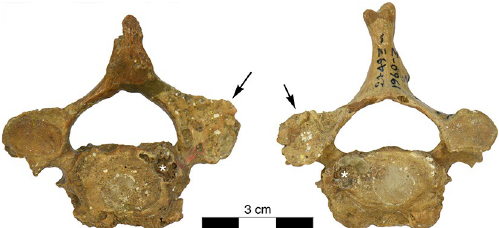
Figure 3. La Chapelle-aux-Saints 1 cervical vertebra 4, inferior view (left) and cervical vertebra 5, superior view (right). The right facet joint of C4/C5 is severely remodelled and shows multiple fine erosions (arrows). White asterisks (*) denote taphonomic damage to the vertebral surface.